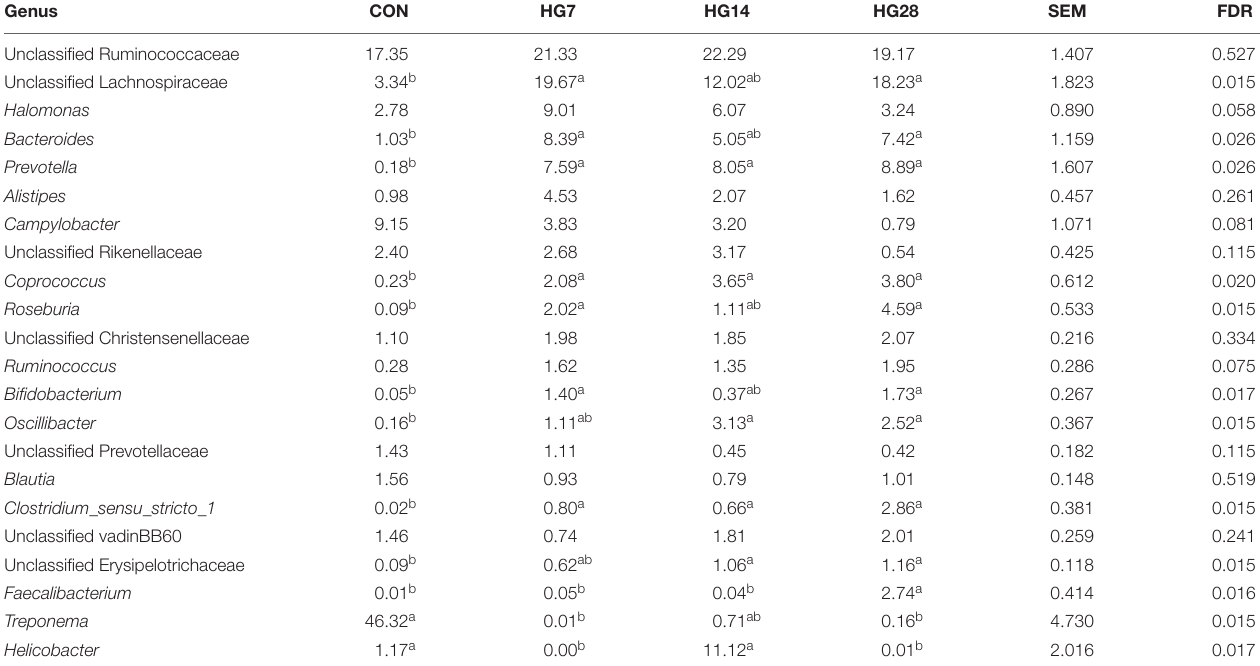
TABLE 4 | Effects of feeding a high-grain (HG) diet on average relative abundance of taxa (% of total sequences) in colonic